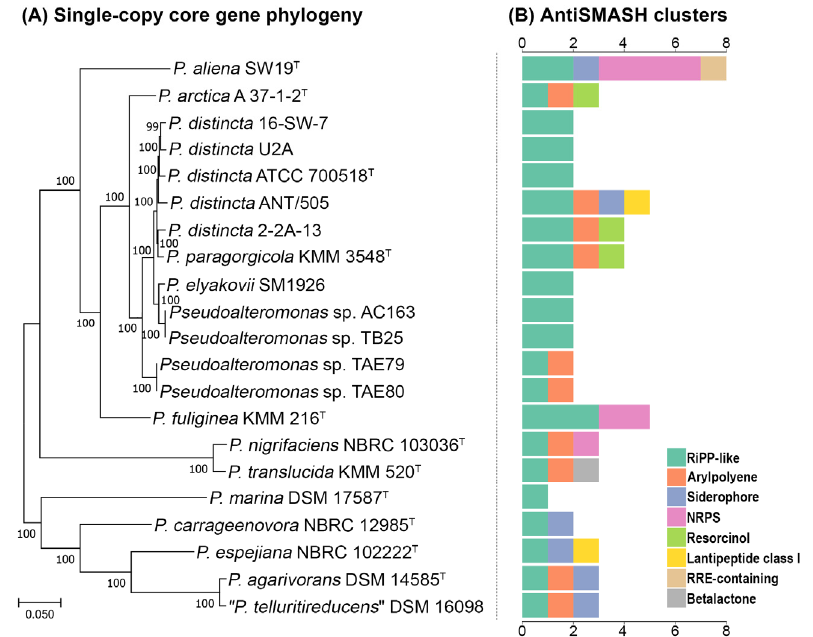
Figure 5. ( A ) Maximum-likelihood phylogeny of twenty-one Pseudoalteromonas strains based on 1369 core genes selected by Roary and reconstructed by IQ-TREE and ( B ) distribution of secondary metabolism biosynthetic gene clusters (BGCs) across the genomes.